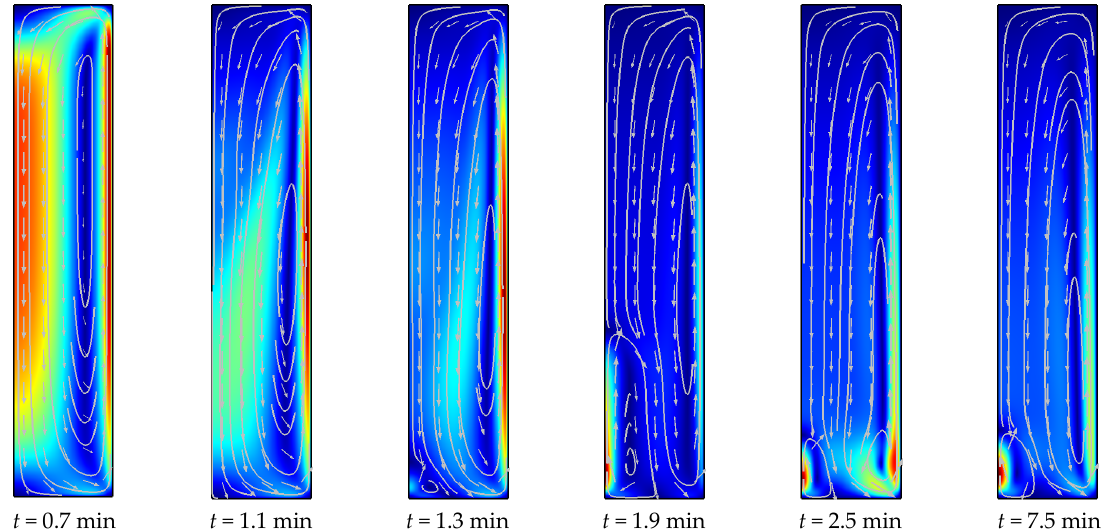
Figure 4. Flow patterns shown by velocity magnitude and arrows in the half cylinder cross-section for the heating experiment (maximum velocities in the subplots from left to right: 2.2, 2.4, 1.9, 3.9, 1.3, 1.0 mm/s).